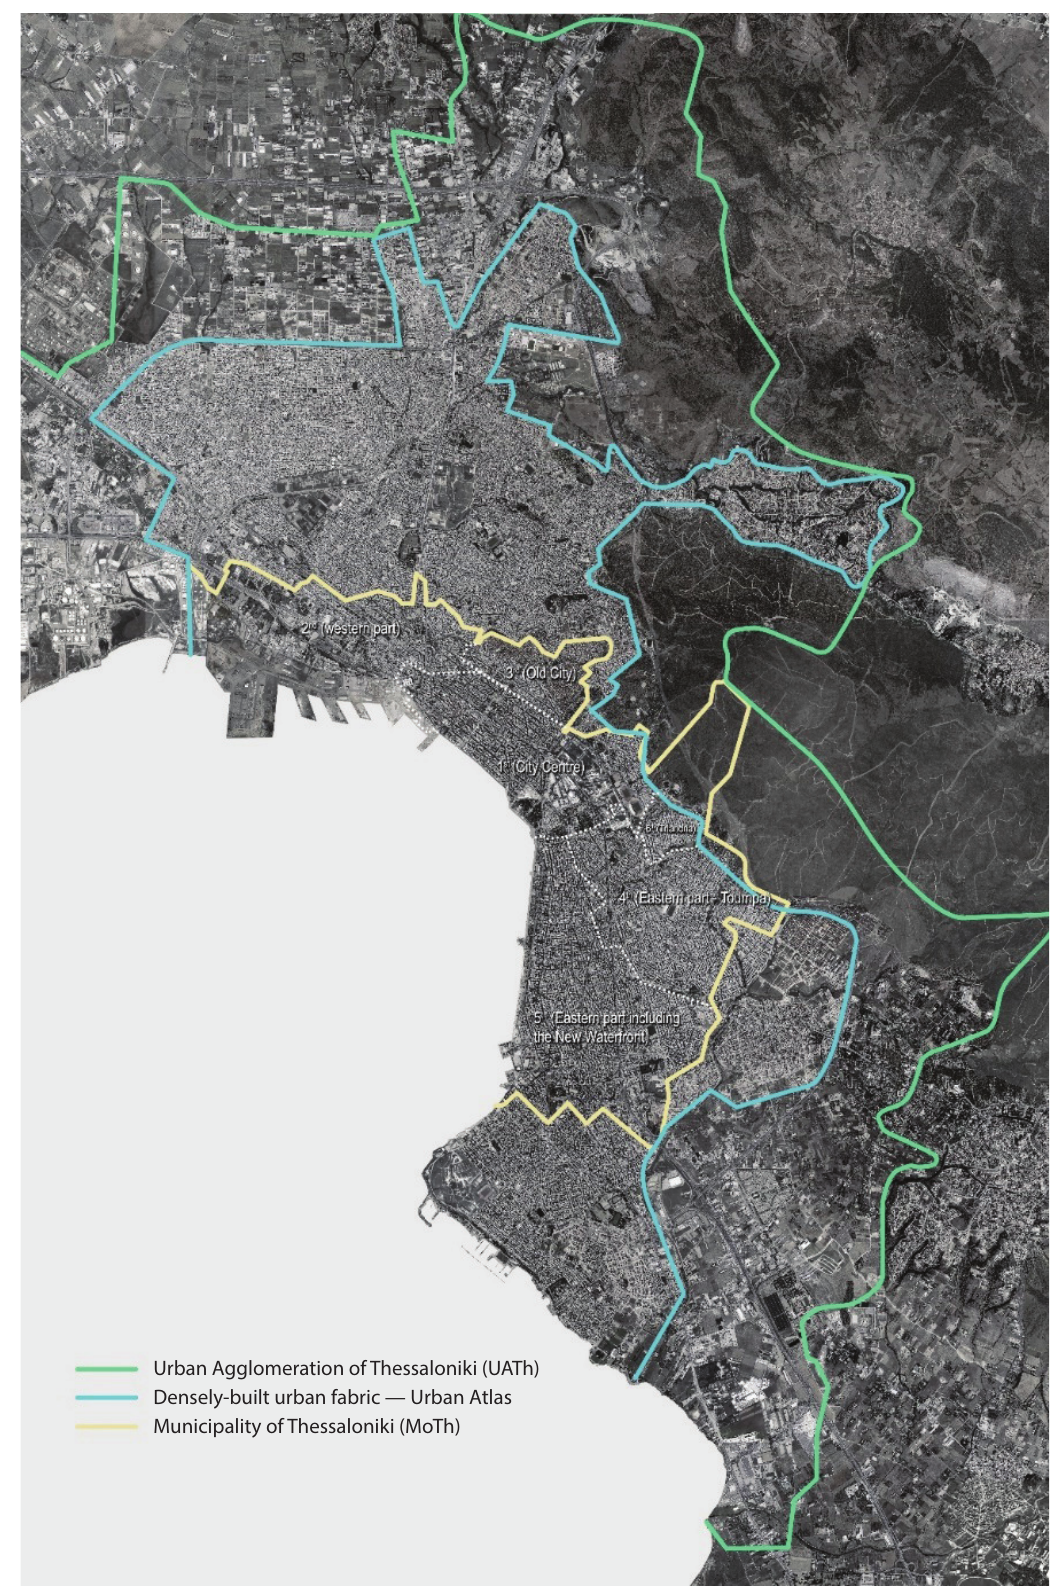
Figure 1. The Urban Agglomeration of Thessaloniki, the densely built urban fabric, and the MoTh with its six municipal boroughs. Source: Created by the author with images from Google Earth and the Greek National Cadastre and Mapping Agency S. A.